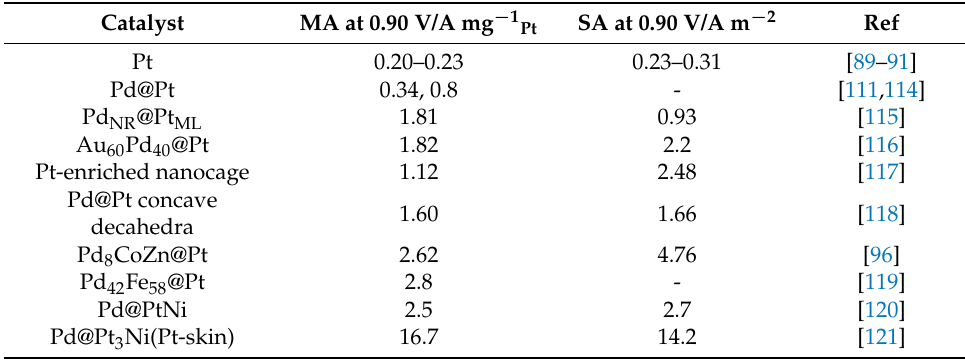
Table 4. MA and specific activity (SA) at 0.9 V versus RHE for the ORR of various Pd or